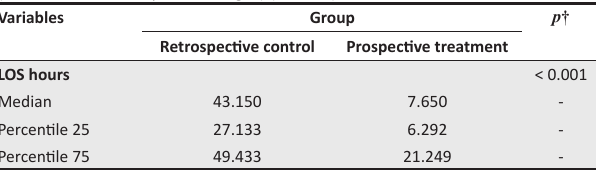
TABLE 3: Comparison of hospital length of stay in hours between groups (medians and inter-quartile ranges) ( n = 120).